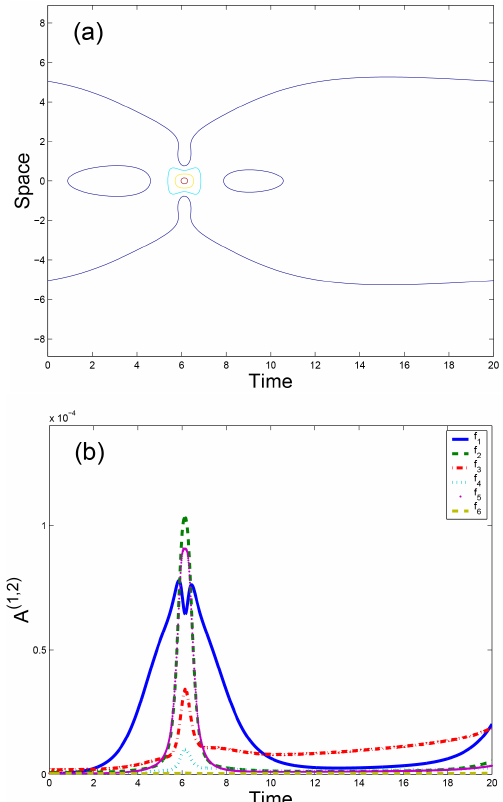
Figure 11. (a) Contours of | U (cid:15) (x,t) | in the coalesced case for f 5 (x) (dashed line) and of the two-mode SPB | U ( 1 , 2 ) (x,t ; ρ ∗ ,τ ∗ ) | (solid (t) for each f i line). (b) Evolution of A ( 1 , 2 ) i